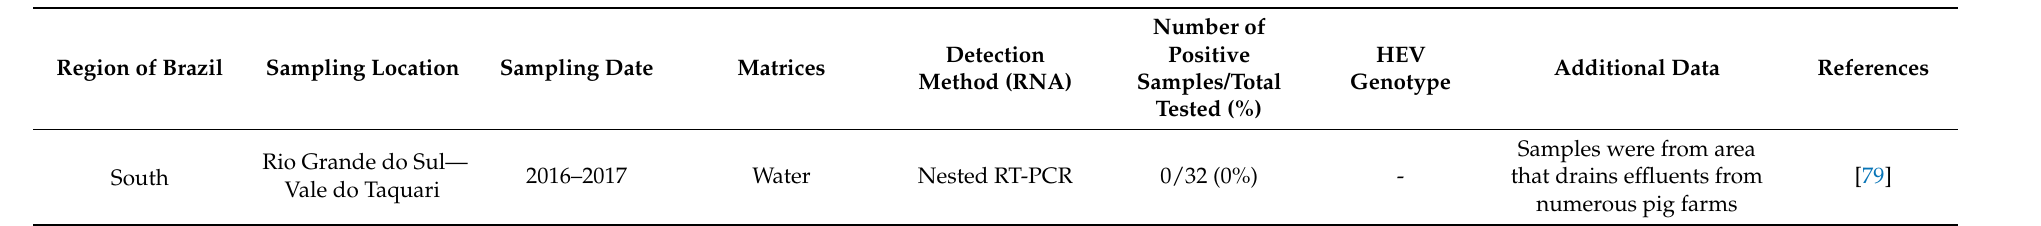
Table 4. HEV in environmental samples,